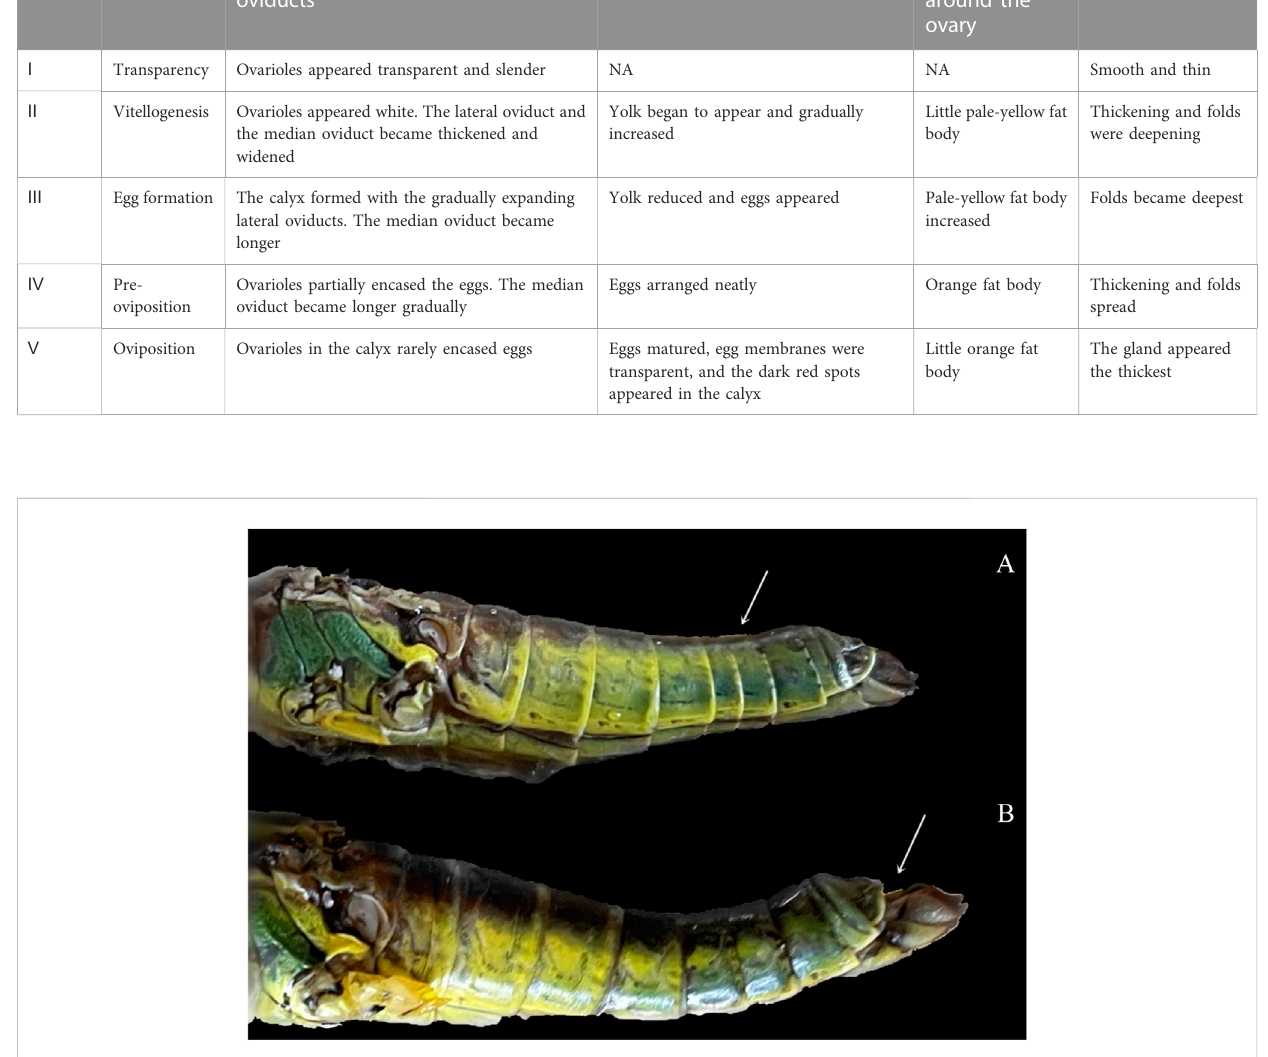
FIGURE 2 Phenotypic morphology of the C. kiangsu abdomen at (A) stage Ⅳ and (B) stage Ⅴ